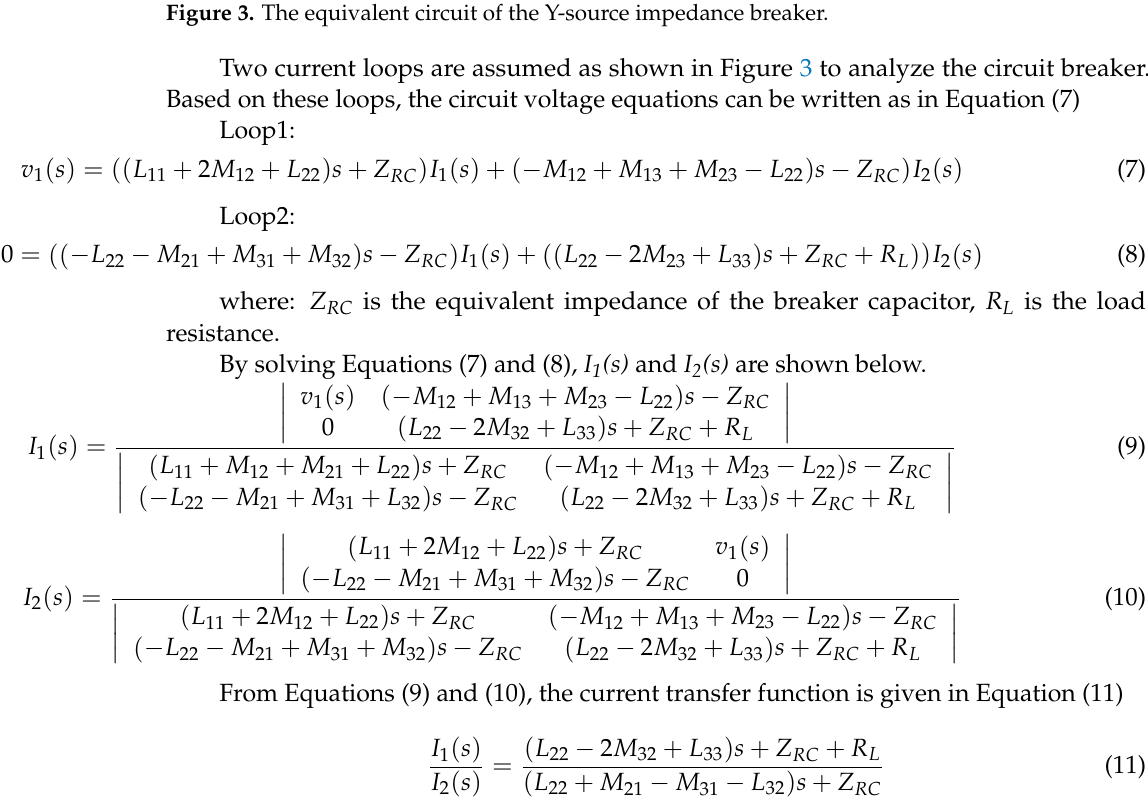
Figure 3. The equivalent circuit of the Y-source impedance breaker.